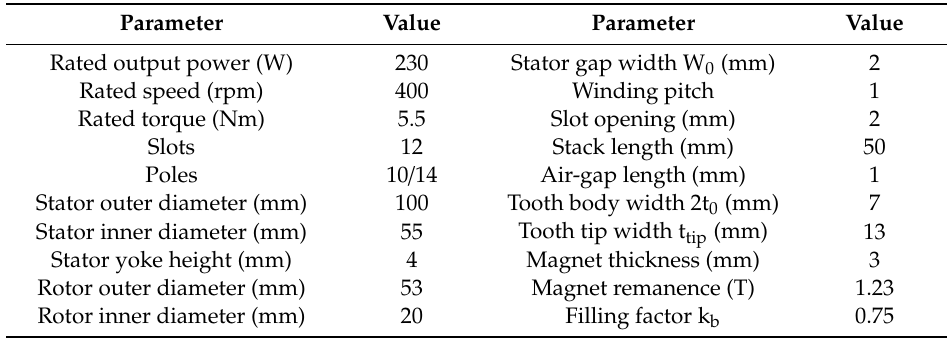
Table 1. Design parameters of the investigated